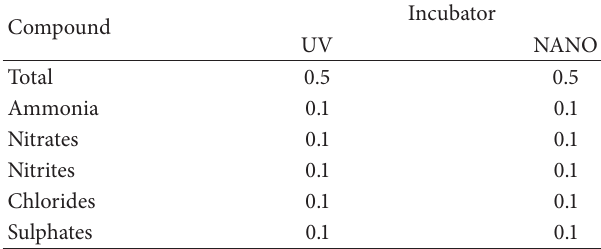
Table 13: Concentration of inorganic gaseous compounds in the air inside the incubators on the 17th day of incubation [mg/m 3